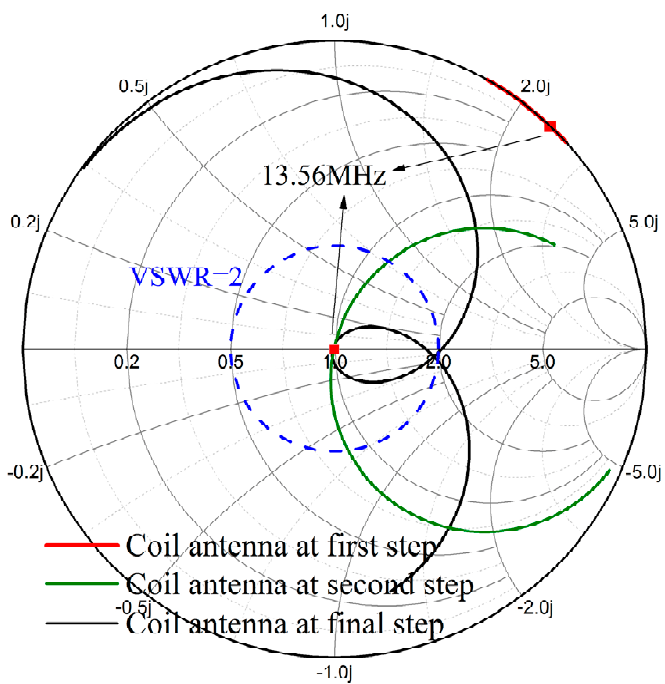
Figure 11. The final state of interim and ultimate systems on the Smith